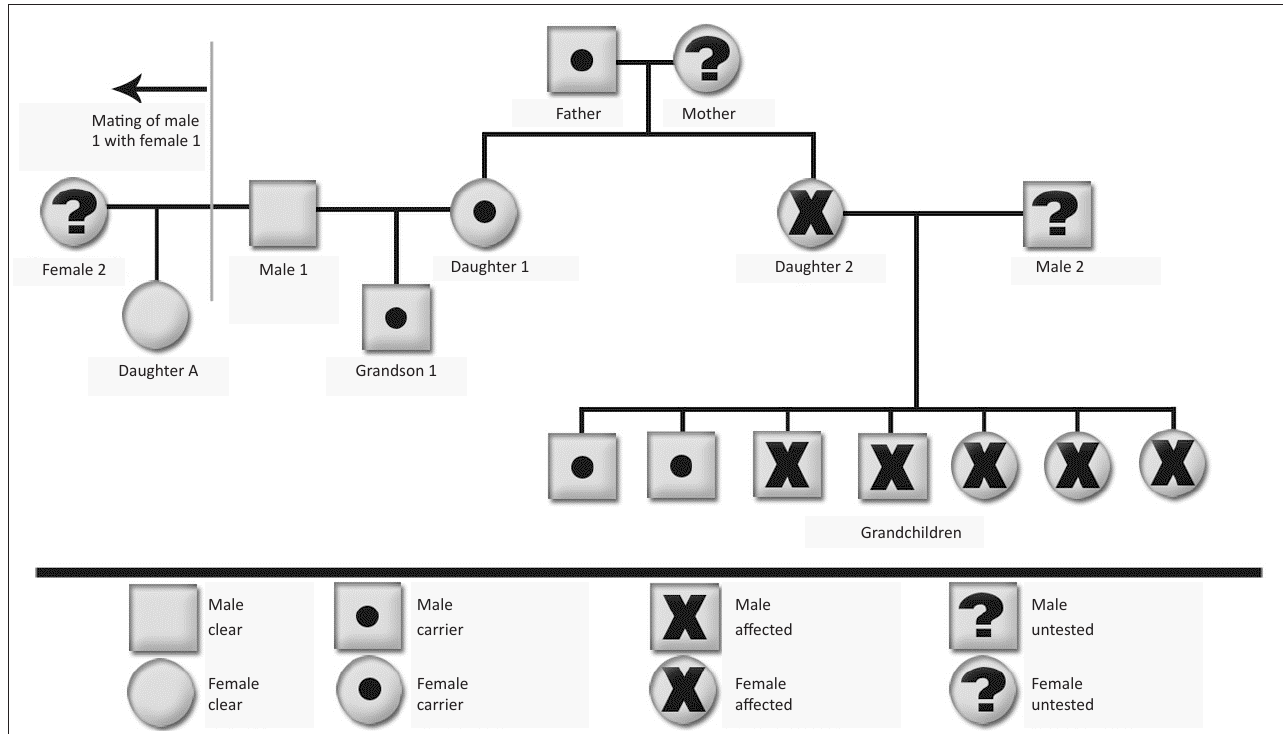
Mating of male 1 with female